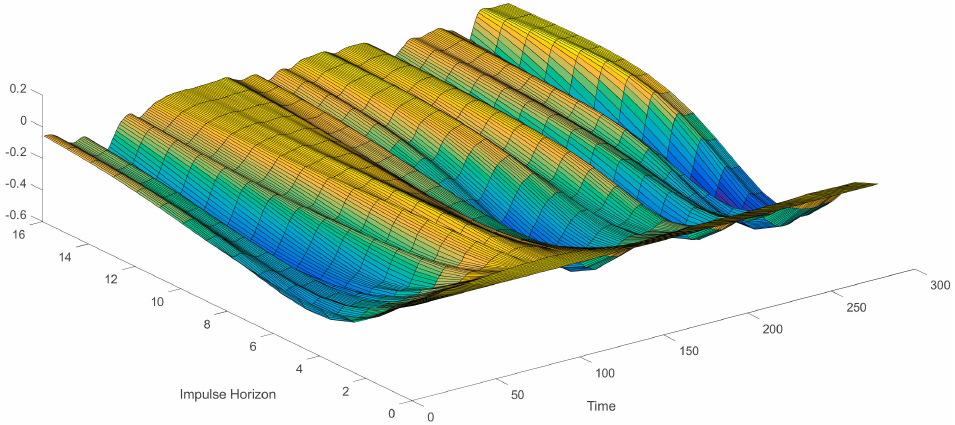
Figure 6. Impulse response function of the exchange rate due to a change in the level of the oil price, for 16 months and in each moment from 1996M3 up until 2019M4 (Time